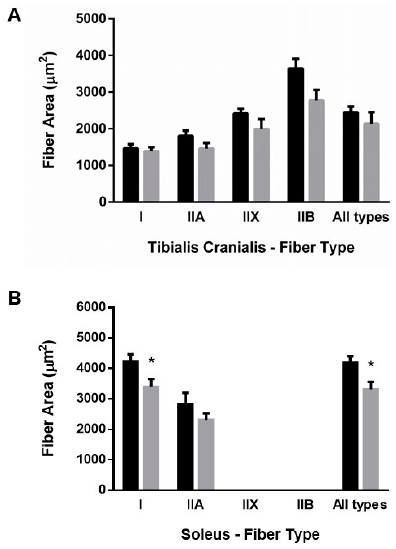
Figure 3. Mean fiber cross-sectional area of ( A ) tibialis cranialis and ( B ) soleus muscles. Student’s t-test between control (black bars) and energy-restricted (grey bars) groups. * p < 0.05 vs. control.